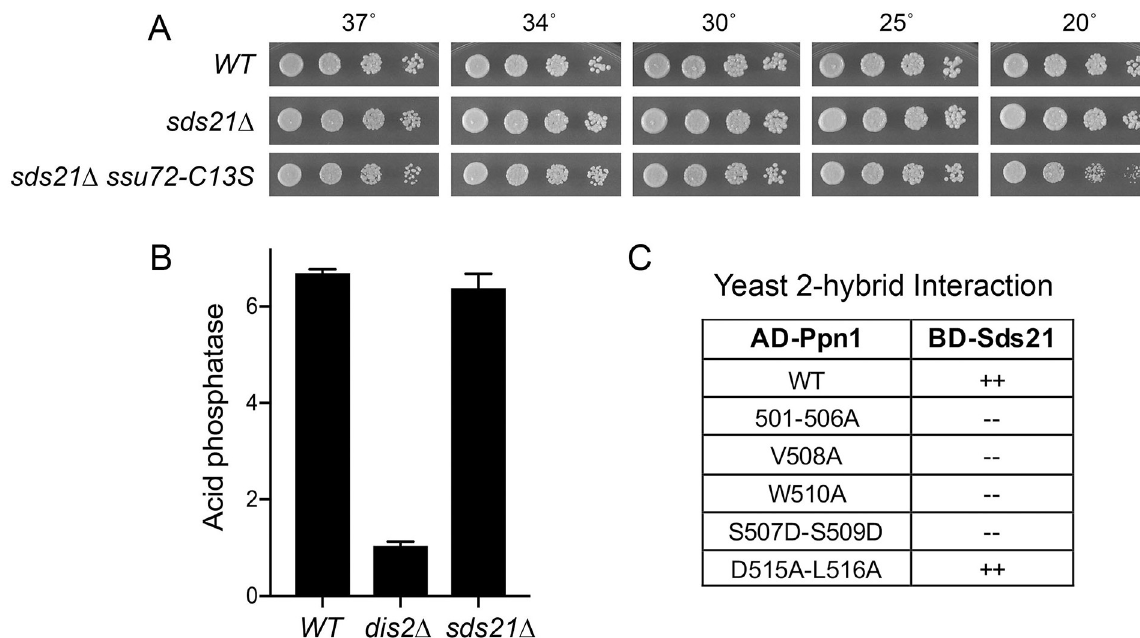
Fig 13. Sds21 can interact with Ppn1 via the Dis2 binding site. (A) S . pombe wild-type, sds21 Δ , and sds21 Δ ssu72-C13S strains were spot-tested for growth on YES agar at the indicated temperatures. (B) S . pombe wild-type, dis2 Δ , and sds21 Δ cells were grown in liquid culture at 30˚C and assayed for acid phosphatase activity. (C) Full-length Ppn1 (WT and the indicated mutants) fused to the Gal4 AD were tested for 2-hybrid interactions with Gal4 BD fusions to full-length Sds21. AD/BD pairs that scored positive in both reporter assays (LacZ expression and histidine prototrophy) are indicated as ++. Pairs that were negative in both reporter assays are scored as --.